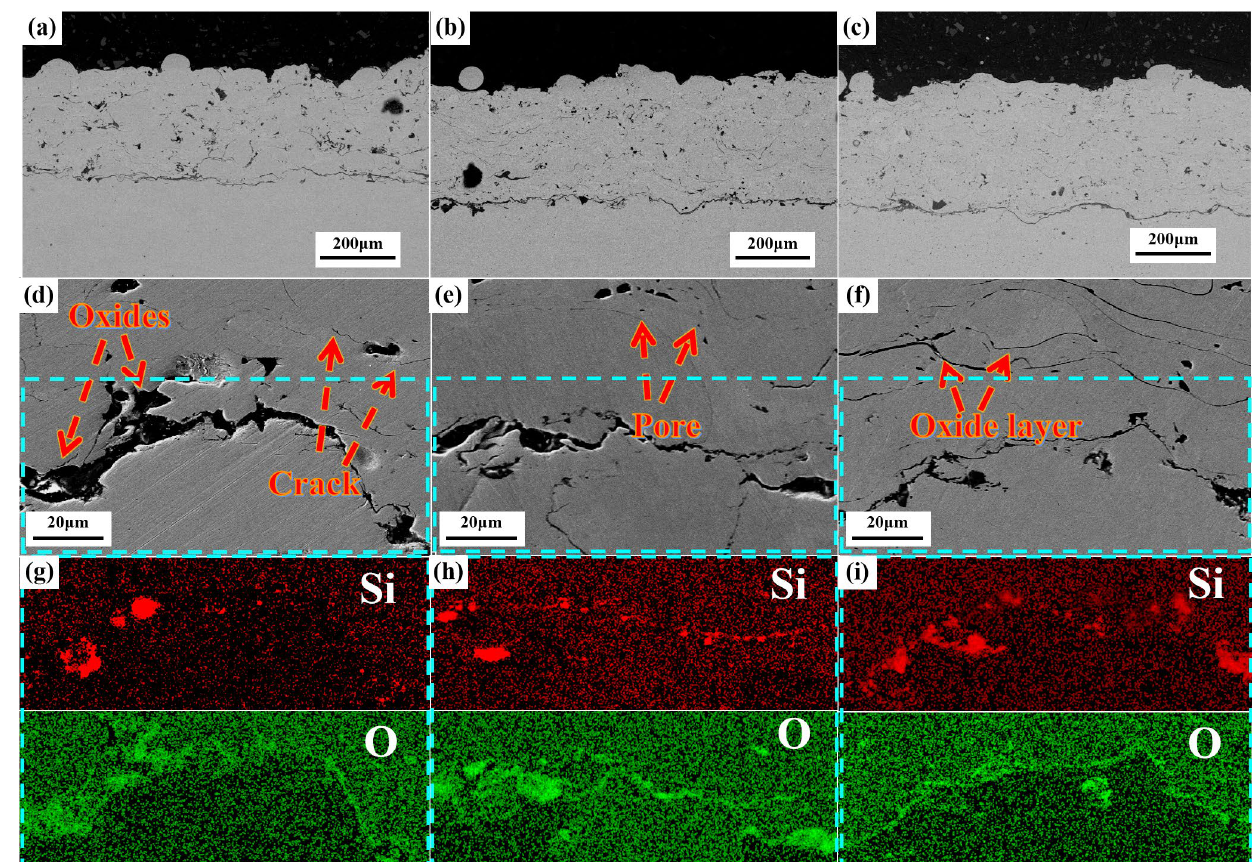
Figure 2. Cross- sectional SEM morphologies and EDS analysis of the coatings: ( a , d , g ) Fe-based coating, ( b , e , h ) 6% γ -Fe coating, ( c , f , i ) 9% γ -Fe coating.